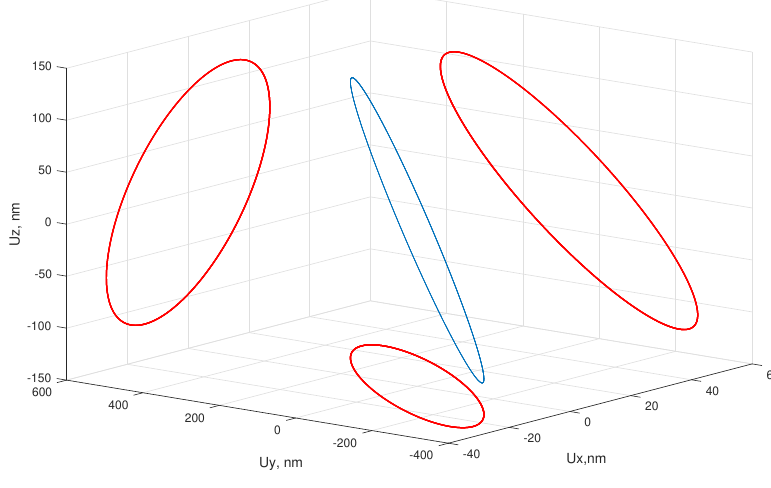
Figure 7. Trajectories of the contact